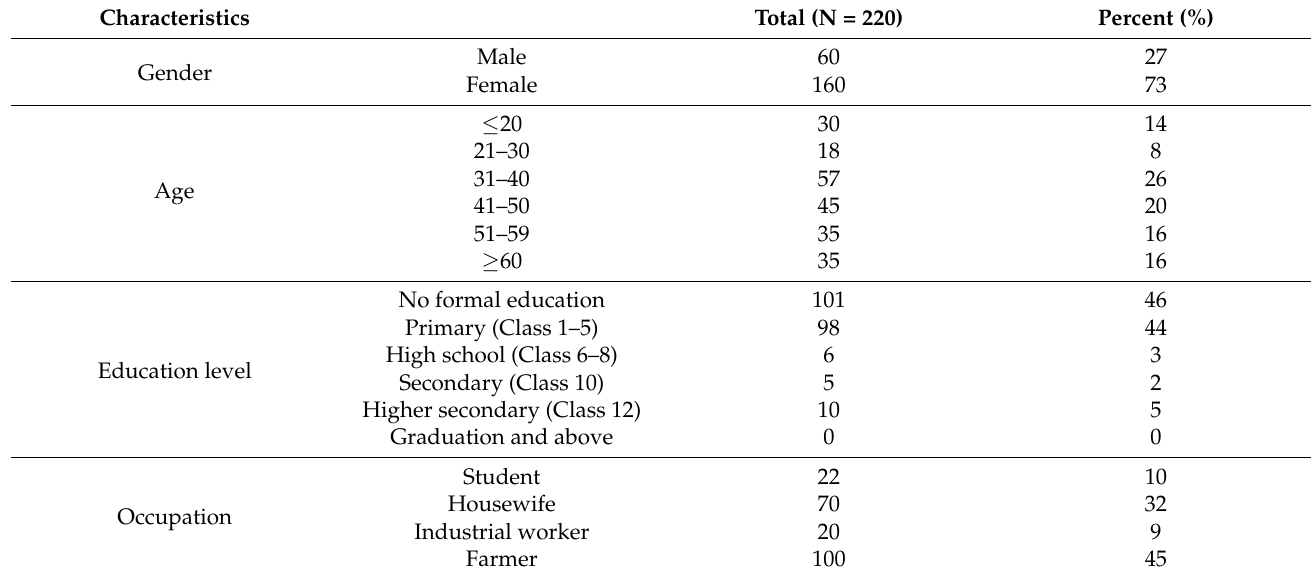
Table 5. Characteristics of the respondents participated in the household survey.